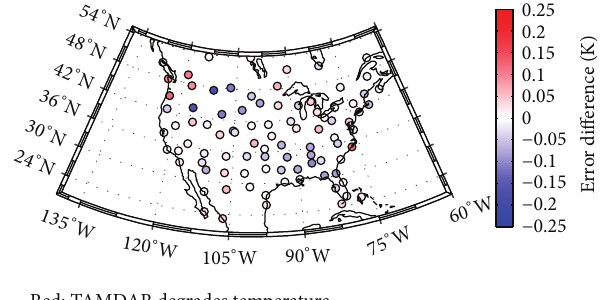
Figure 6: Spatial patterns of the mean absolute error differences in temperature (K) for Domain 1 averaged over the 400 to 600hPa layer and over the 6-day simulation period. Blue colors indicate improvement of the model biases by assimilating the TAMDAR data while red colors indicate